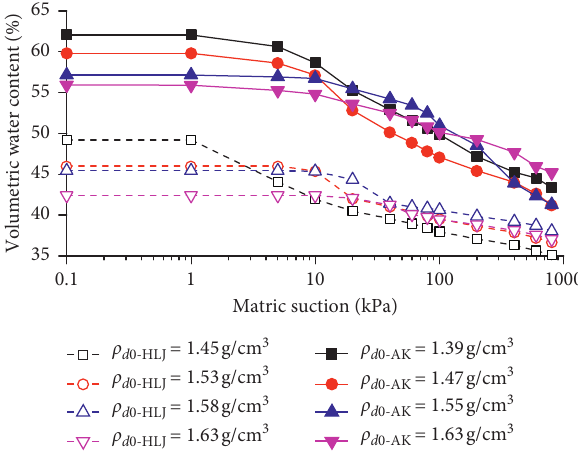
Figure 6: The SWCCs under different initial dry densities. Figure 5: The curves of void ratio with matric suction under